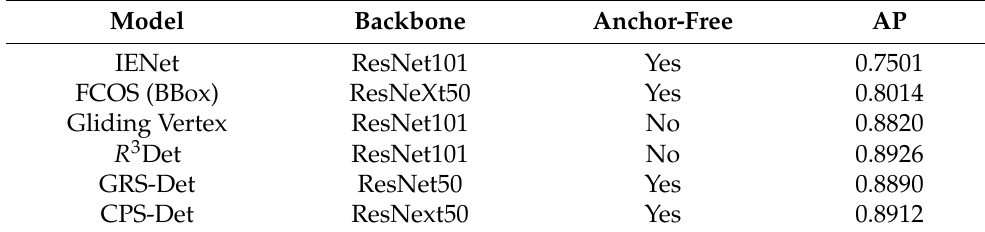
Table 4. Overall performance comparisons on HRSC2016 dataset.